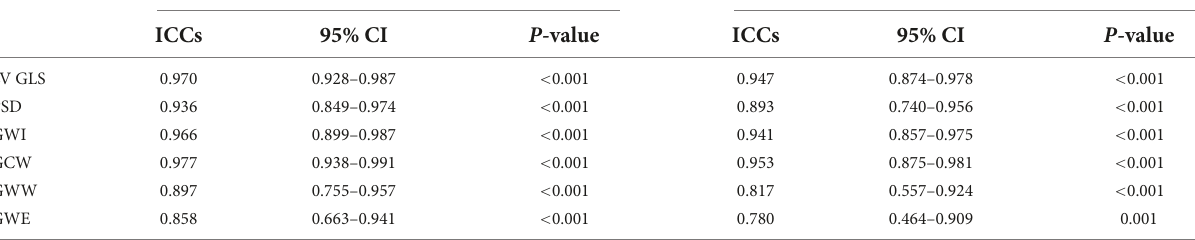
TABLE 5 Intra-observer and inter-observer variability. Intra-observer